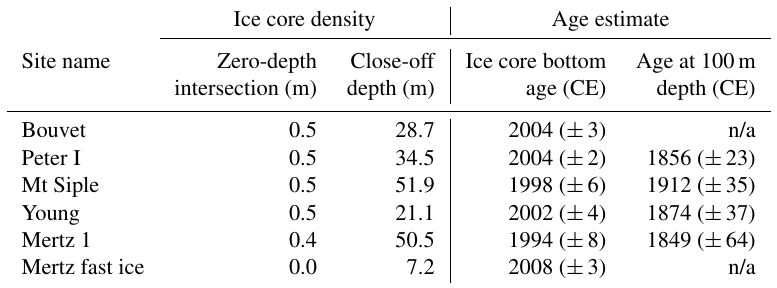
Table 3. Ice-core-derived zero-depth intersection and close-off depth. Estimated age (years CE) at the bottom of the core and at 100m, based on the measured ice core